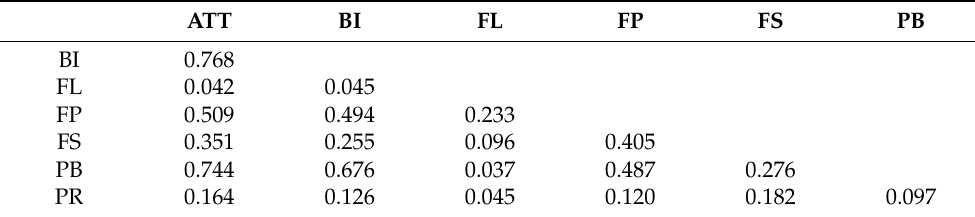
Table 3. Heterotrait–Monotrait Ratio (HTMT). ATT